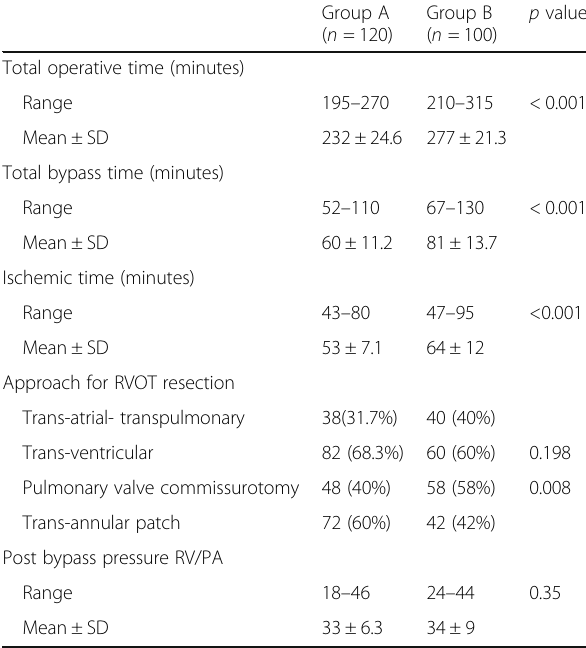
Table 2 Operative data (continuous variables are presented as mean, standard deviation, and range and categorical data as number and percent) ( RVOT right ventricular outflow tract, RV right ventricle, PA pulmonary artery)